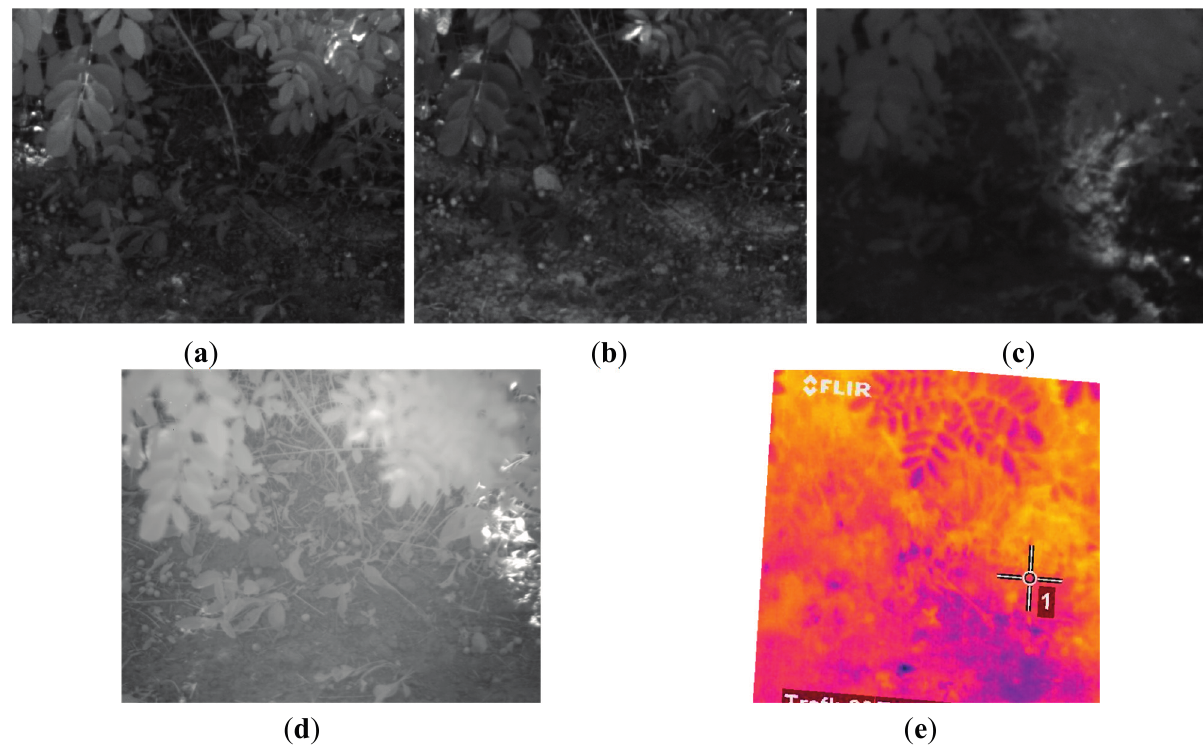
Figure 18. Registered images. ( a ) Registered monochrome image; ( b ) Registered 624 nm image; ( c ) Registered 950 nm image; ( d ) Registered SWIR image; ( e ) Registered LWIR